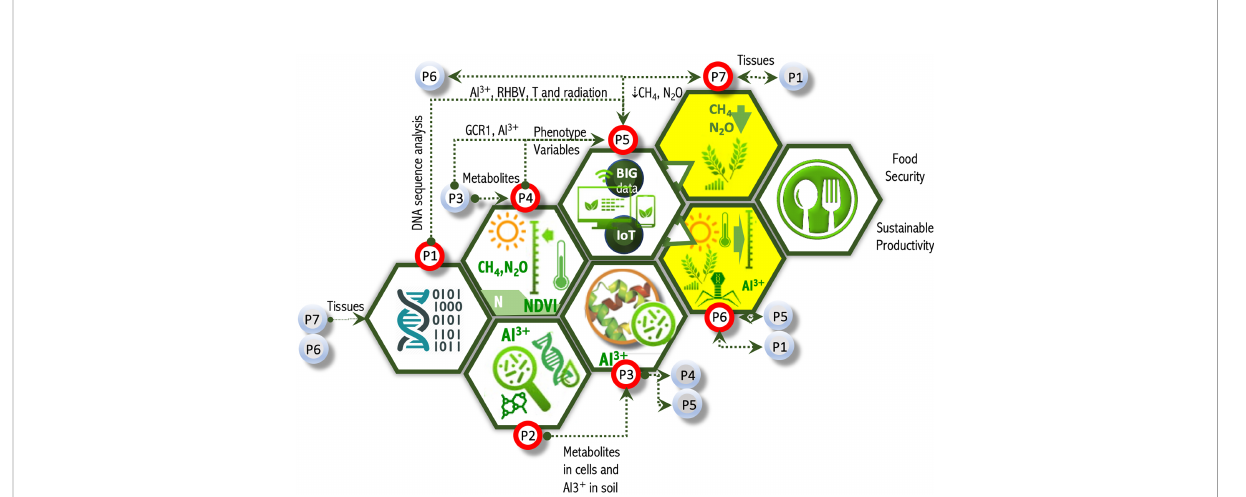
FIGURE 4 OMICAS program architecture, its macroprojects and their parameter-driven couplings. This fi gure depicts a sub-set of the basic data couplings in the OMICAS strategy. For example, P1 receives plant tissues from P6 and P7, and outputs DNA/RNA sequences for the modeling efforts in P5; P2 validates sensor technologies on metabolomics and ionomics characterized in P3; P3, in turn, contributes metabolomic and ionomic data for the high-throughput phenotyping effort in P4, and for the development of predictive models in P5; P4 uses molecular and elemental information from P2 and P3, and produces continuum-level phenotypic data for the models and codes developed in P5; while P5, integrates the experimental (physical and computational) multi-omics characterizations from P1-P4 into complex models derived from graph- and network theory, machine learning, and other mathematical and computer science methods to produce predictive tools for in-silico analysis and breeding optimization; P6 and P7 contribute breeding of new plant varieties with improved agronomic traits, based on the in-silico results from P5, and feeds tissues, soil and other environmental samples into the characterization and modeling that occur within